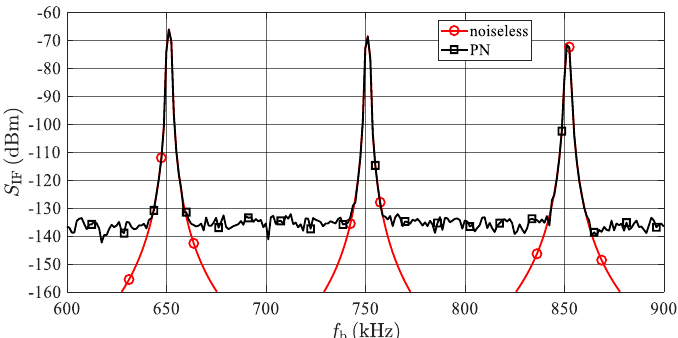
Figure 14. Simulation of beat signals at the AR sensor’s receiver coming from three targets at distances of 13, 15 and 17 m with an RCS 100 m 2 . In the “noiseless” case, the AR and TS are considered to be noiseless, and the only factors worsening the detection of targets is a main lobe of the Hann window utilized in the FFT processing. The “PN” case introduces phase noise to the LO signal in TS according to Figure 7. Thanks to the summation of noise contributions from both side targets, the center target is degraded, as predicted in Figure 9.